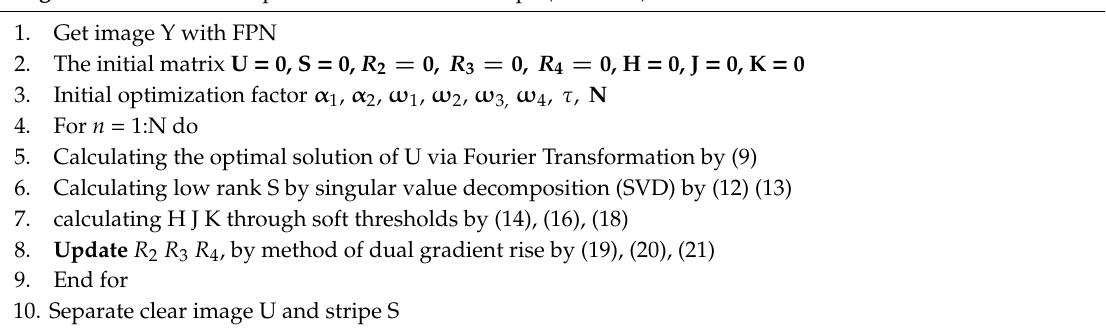
Algorithm 1 Low-Rank sparase variationnal destripe